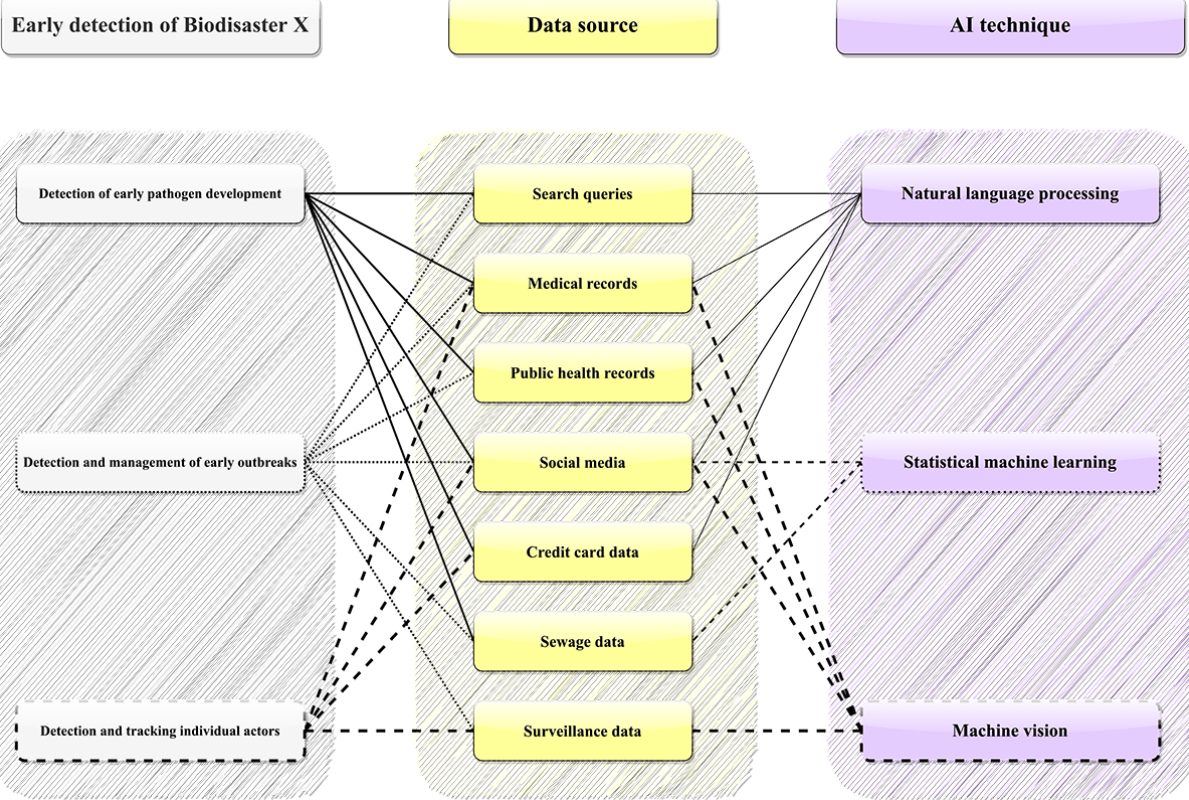
Figure 2. Artificial Intelligence techniques discussed in detail in the study. Statistical machine learning refers to techniques that do not involve natural language processing or deep learning processes. AI: artificial